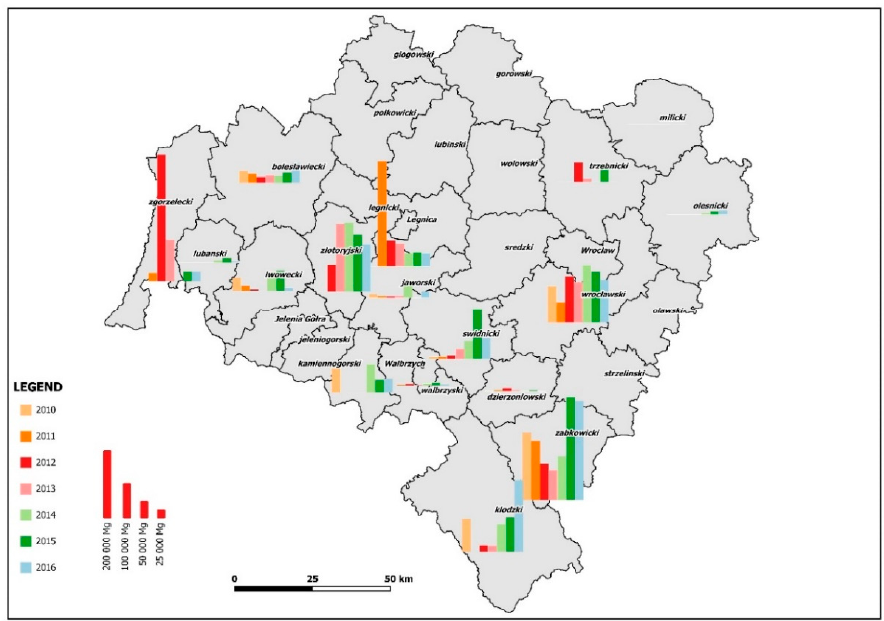
Figure 4. Waste generated in rock mineral mining year by year (2010–2016) in administrative units of the Lower Silesia Province [Mg].